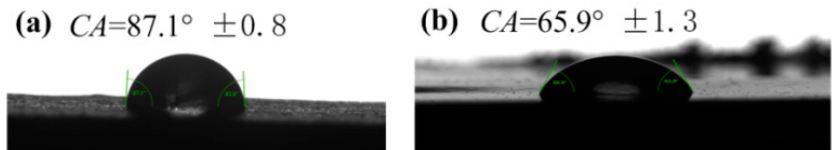
Figure 7. Static water contact angle (CA) of water droplets on the different specimen surfaces: ( a ) on UHMWPE; ( b ) on porous UHMWPE/FANC 12.5 . The immersion time was 4 s for these samples.